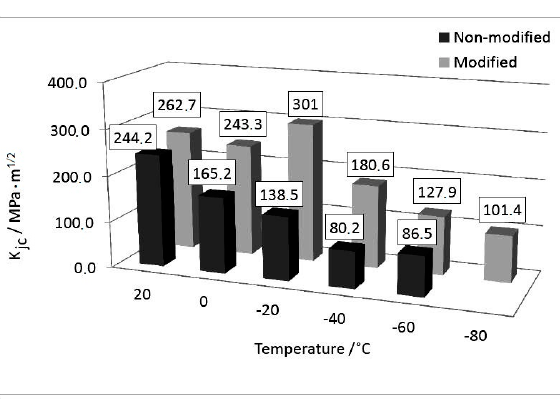
Figure 2. G17CrMo5-5 fracture toughness diagram.